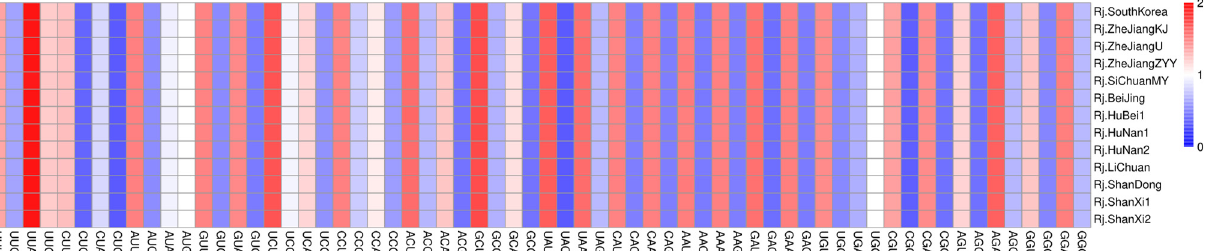
Figure 4. The RSCU values of all the concatenated protein-coding genes for the 13 R. japonica chlo- roplast genomes.